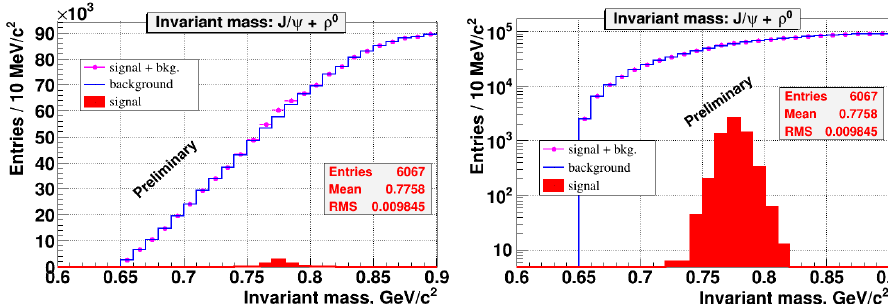
Figure 6. Invariant mass combination Me + e − π + π - - Me + e −